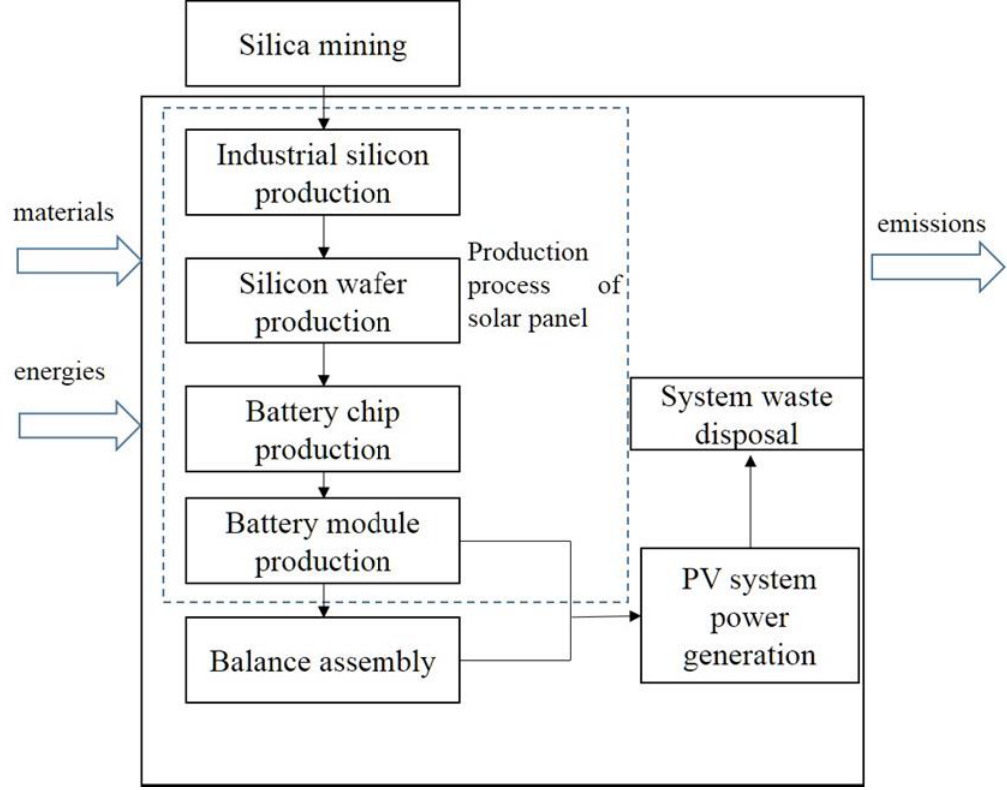
Figure 2. Boundary diagram of the photovoltaic power generation system.